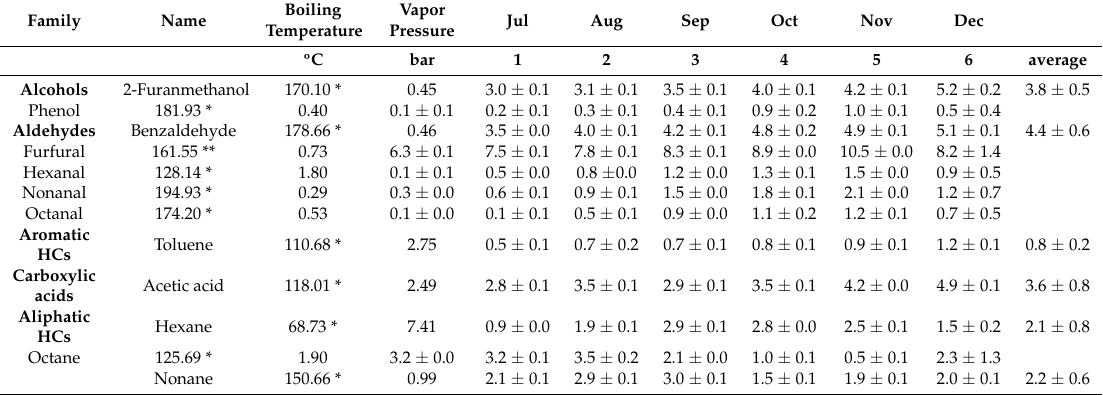
Table 4. Normal boiling temperature, vapor pressure at 150 ◦ C and the concentration of target VOCs in ppm v in exhaust gases during alperujo drying.